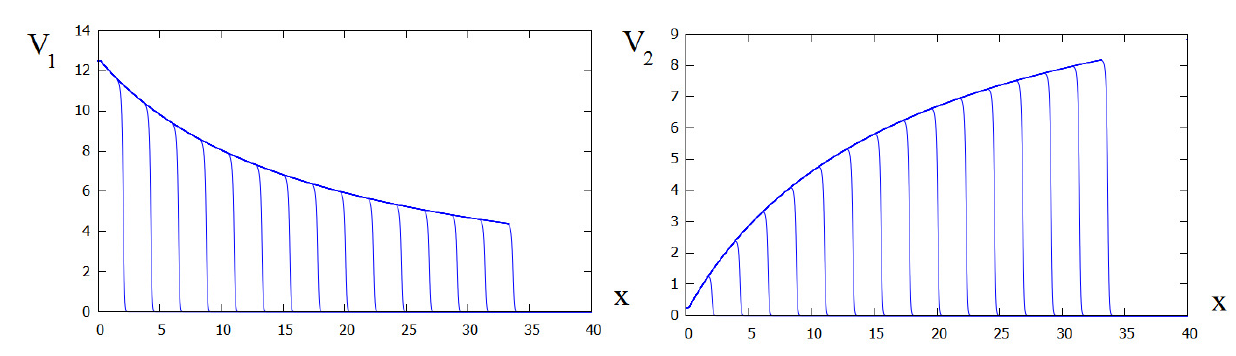
Figure 2. Numerical simulations of system (29)–(33) in the case where a 1 = a 2 , b 1 = b 2 . Both virus spread in the form of waves, but the concentration of the first virus slowly decreases while of the second virus increases. The values of parameters: a 1 = 0.01, a 2 = 0.01, b 1 = b 2 = 80,000; D 1 = D 2 = 10 − 3 , β 1 = β 2 = 0.1, σ 1 = σ 2 = 1, τ = 2, u 0 = 1, i 10 = i 20 = 0, v 1,0 = 4.5, v 2,0 = 0, x 0 =